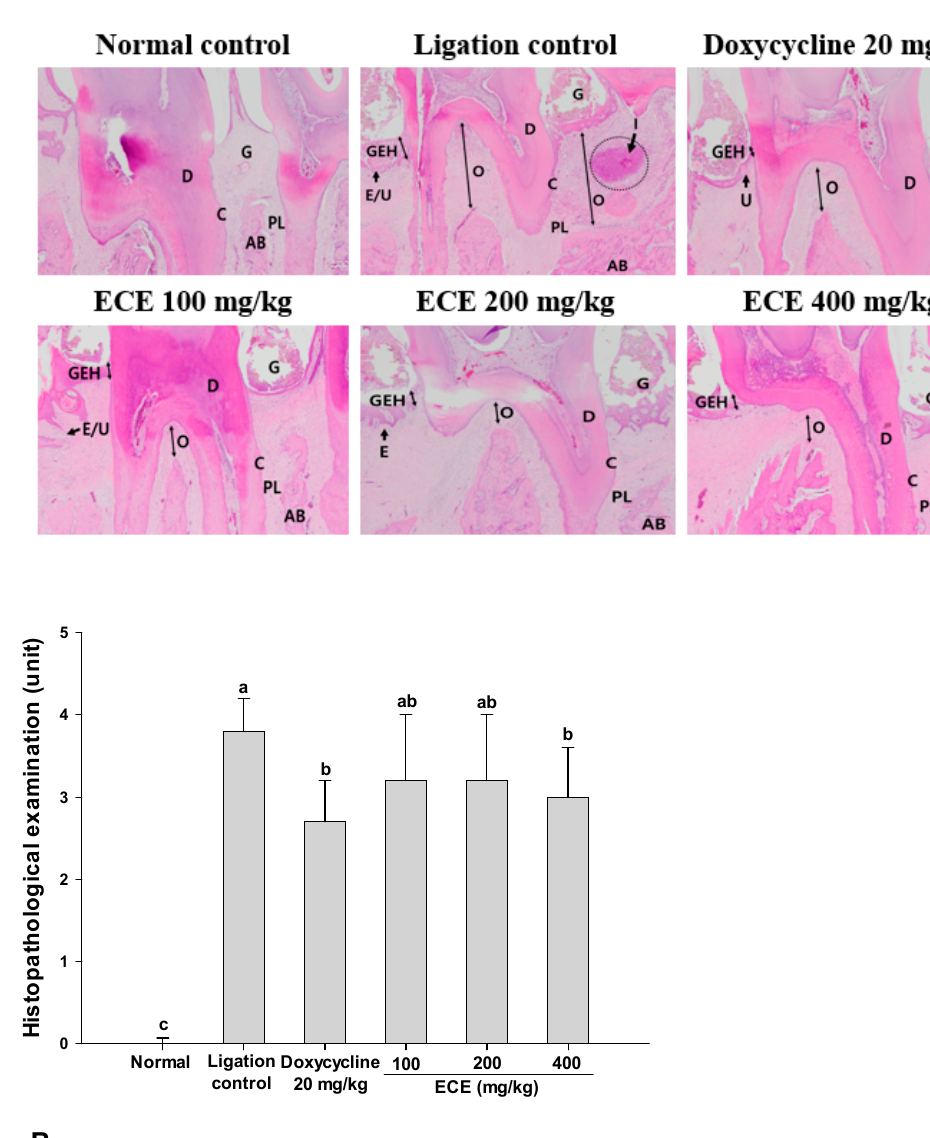
Figure 4. Effects of ECE on alveolar bone loss (A), and (B) histopathological analysis in ligature-induced periodontitis rats. (A) Three-dimensional micro-CT images of the right mandibular second molars. The images were used to measure the distance between the cementoenamel junction. The average of cementoenamel junction (CEJ)–alveolar bone crest (ABC) distances was used as an index of alveolar bone loss. (B) Histopathological examination index were measured from H&E staining. Data are presented as mean ± SD ( n = 6) and b ars with different letters indicate significant differences at p < 0.05. ECE: Ecklonia cava extract, D: dentin, G: gingiva, C: cementum, PL: periodontal ligament,